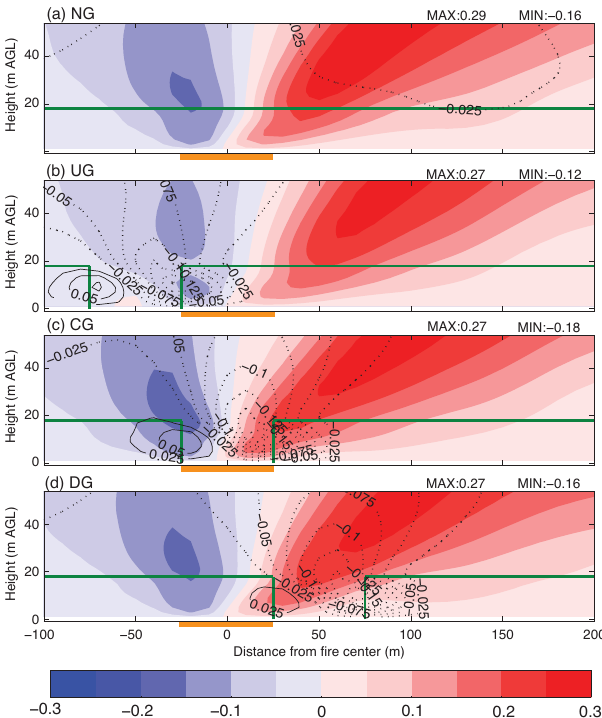
Figure 3. As in Fig. 2 but for vertical velocity (ms − 1 ); contour interval is 0.025ms − 1 , and shading interval is 0.05ms − 1 . (i.e., west) side of the gap (solid lines) and a broad downdraft on the downwind (i.e., east) side of the gap (dashed